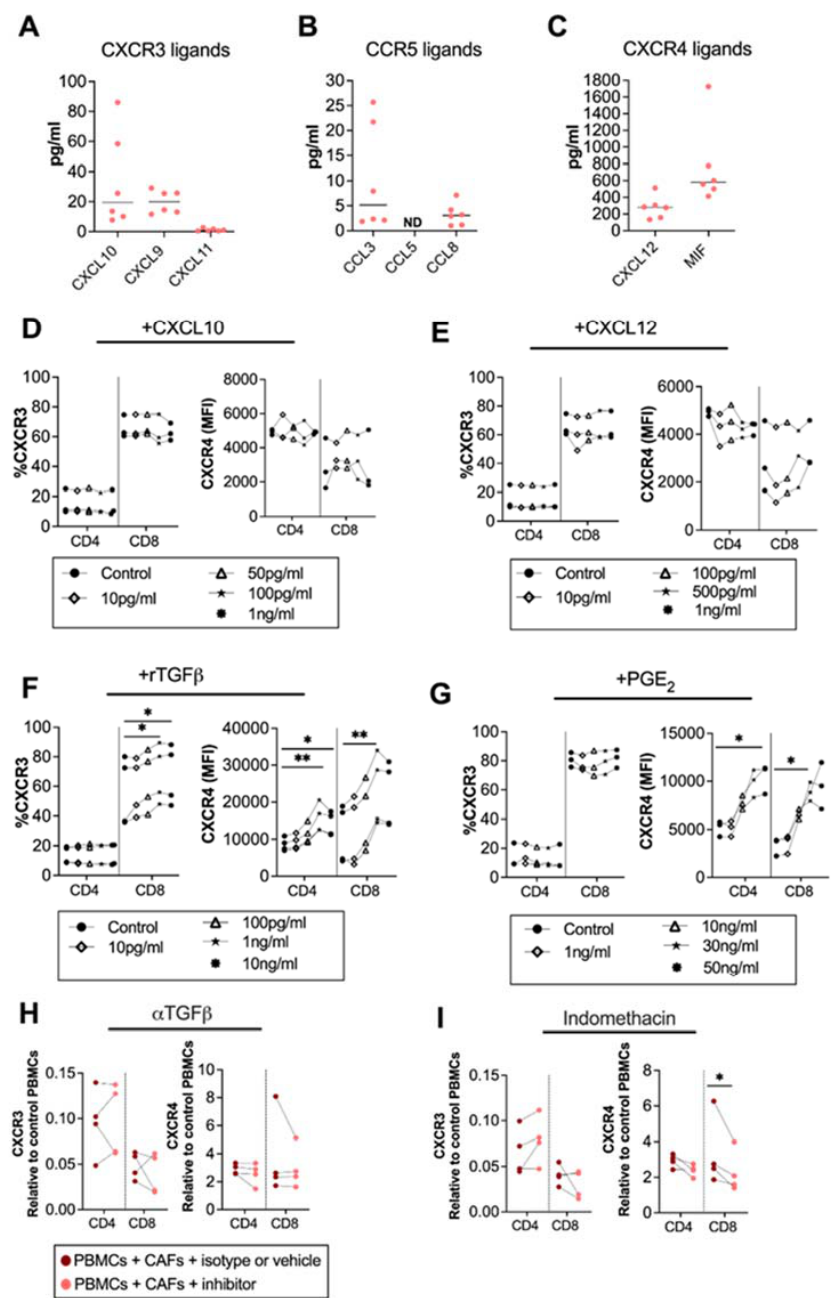
Figure 2. CAF ‐ released CXCL10, CXCL12 and TGF ‐β are not involved in CAF ‐ mediated modulation of chemokine receptors, but PGE 2 partially modulates CXCR4. Levels of ( A ) CXCL10, CXCL9 and CXCL11; ( B ) CCL5, CCL3, and CCL8; and ( C ) CXCL12, and MIF in CAF ‐ conditioned medium ( n = 6). ( D – G ) Frequencies of ( left ) CXCR3 and ( right ) CXCR4 expression in CD4 + and CD8 + T cells after adding different concentrations of ( D ) CXCL10 (10 pg/mL, 50 pg/mL, 100 pg/mL, 1 ng/mL); ( E ) CXCL12 (10 pg/mL, 100 pg/mL, 500 pg/mL, 1 ng/mL); ( F ) rTGF β (10 pg/mL, 100 pg/mL, 1 ng/mL, 10 ng/mL); and ( G ) rPGE 2 (1 ng/mL, 10 ng/mL, 30 ng/mL, 50 ng/mL) to the PBMCs. ( H , I ) Frequencies of ( right ) CXCR3, ( left ) CXCR4 on CD4 + and CD8 + T cells cultured with CAFs after addition of the corresponding isotype, vehicle or the following blocking: ( H ) 5 μ g/mL of anti ‐ TGF β to block TGF ‐β and ( I ) 20 μ M of indomethacin to block PGE 2 . Data are related to those of the control cultures without CAFs. ( D – I ) Dots and lines show paired samples. ( D – G ) Friedman’s test and ( H , I ) a paired t test were used to detect statistically significant differences * p < 0.05, ** p < 0.01.